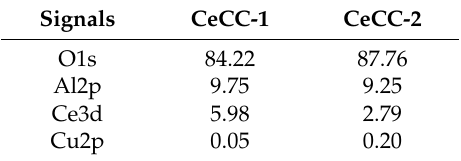
Table 4. Surface composition of samples CeCC-1 and CeCC-2 (at.